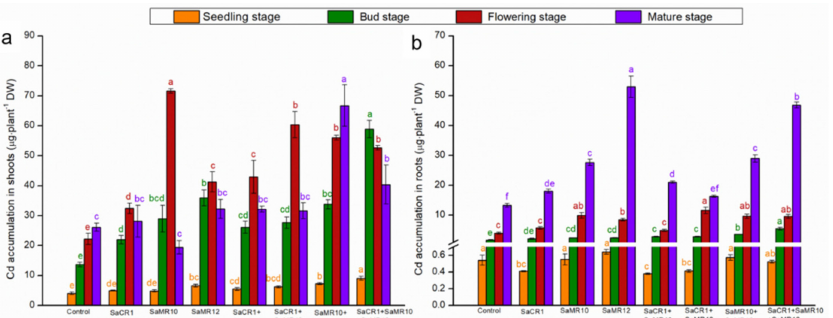
Figure 6. Effects of PGPB inoculants on Cd accumulation in ( a ) shoots and ( b ) roots of B. juncea at different growth stages. Orange, green, red, and purple represent the seedling stage, bud stage, flowering stage, and mature stage, respectively. The letters of corresponding colors indicate the significant differences among different treatments at the same growth stage.